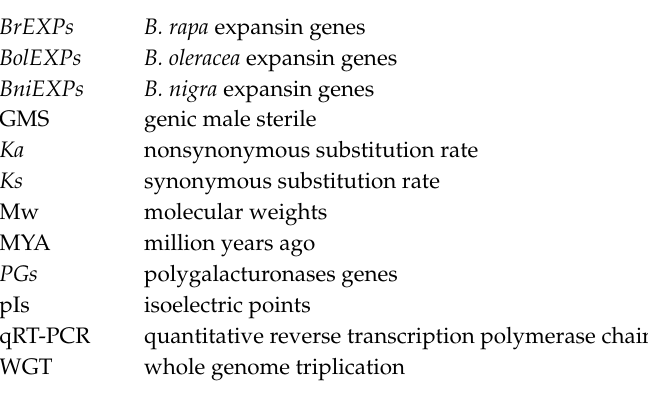
Table S1. Primers used in qRT-PCR analysis of expansin genes in B. nigra and B. oleracea . Table S2. Identification and physicochemical property predictions of expansin genes in A. thaliana , B. rapa , B. oleracea , and B. nigra and nomenclature for the three basic species of Brassica . Table S3. Evolutionary rate analyses of orthologous expansin genes and upstream 500 bp promoters between A. thaliana and B. rapa , A. thaliana and B. oleracea , and A. thaliana and B. nigra . Table S4. Evolutionary rate analyses of paralogous expansin genes and upstream 500 bp promoters in B. rapa , B. oleracea , and B. nigra , respectively. Table S5. Detection of selection for expansin genes using branch model of EasyCodeML in different subgroups. Table S6. The mean evolutionary rates ( Ka , Ks and Ka / Ks ) and promoter divergences ( d SM ) of different subfamilies’ paralogous expansin genes in B. rapa , B. oleracea , and B. nigra . Figure S1. Genomic distribution of expansin genes on chromosomes of A. thaliana , B. rapa , B. oleracea , and B. nigra . Figure S2. The Ka , Ks , Ka / Ks distributions of paralogous expansin gene pairs in B. rapa , B. oleracea , and B. nigra . Figure S3. The d SM distributions of paralogous expansin gene pairs in B. rapa , B. oleracea , and B. nigra